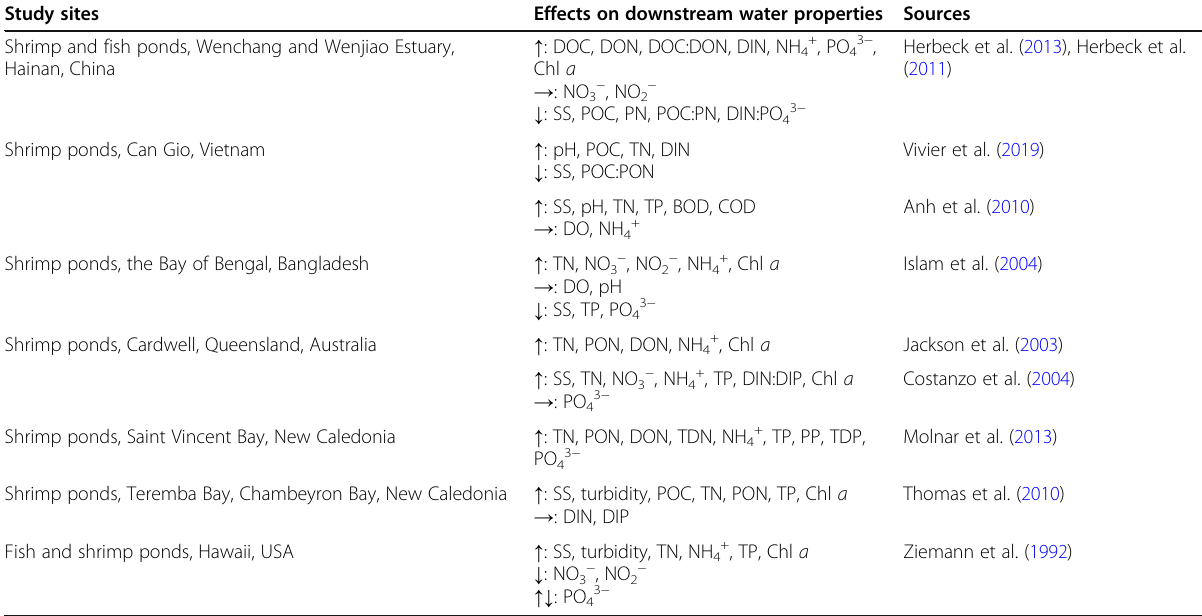
Table 6 A summary of the effects of aquaculture on the downstream riverine and estuarine water properties. The arrows before the water properties indicate that the subsequent water properties increased ( ↑ ), decreased ( ↓ ), or did not change ( → ). See the list of abbreviations for the water